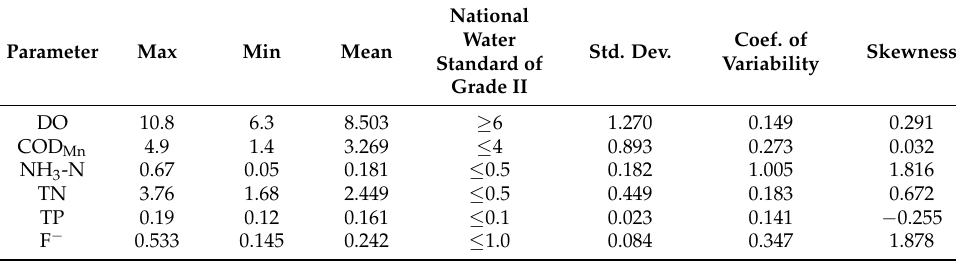
Table 4. Statistical description of midstream water quality indicators (concentration units in mg/L).